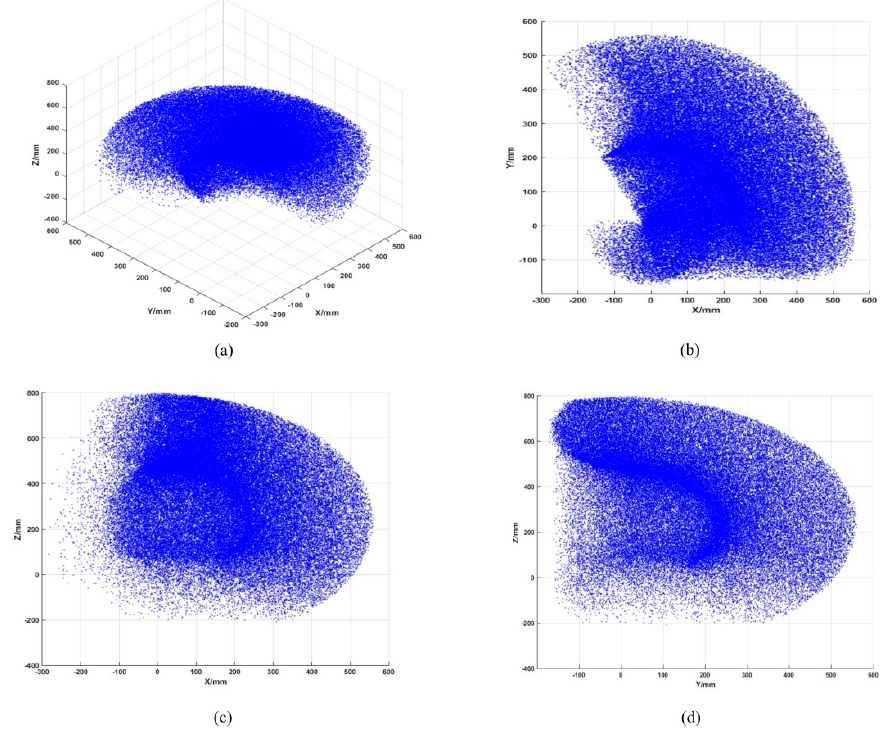
Figure 8. A 3D workspace simulation of the robot: ( a ) 3D spatial diagram; ( b ) XOY view; ( c ) XOZ view; ( d ) YOZ view.